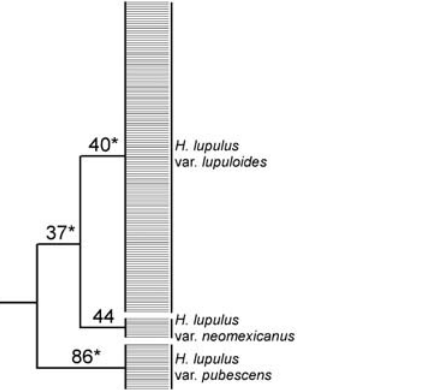
Figure 3. Hierarchical assignment resulting from PCO-MC analysis of Humulus data set. Numbers at nodes are stability values. Asterisks indicate statistically significant clusters (p , 0.05).